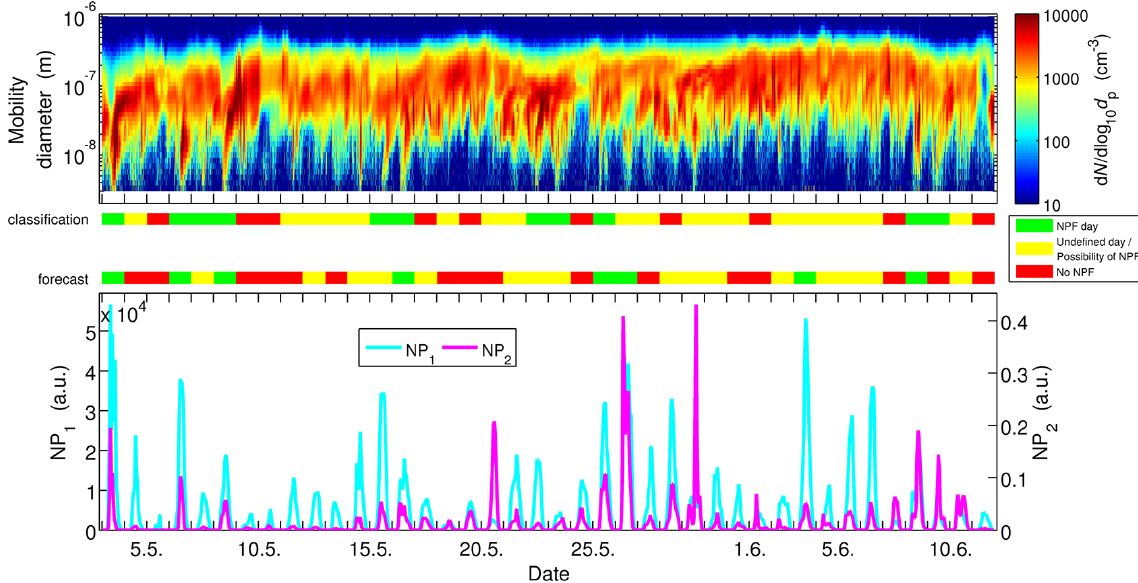
Figure 4. Particle number concentration size distributions (top panel), and nucleation parameters NP 1 and NP 2 (bottom panel) during the campaign time 3 May–11 June 2013. The colour bars between the panels indicate the NPF forecast and classification: green for NPF days, yellow for weak or possible NPF days, and red for non-NPF days (upper colour bar shows the NPF event classification based on the DMPS data, and lower colour bar the forecast for each